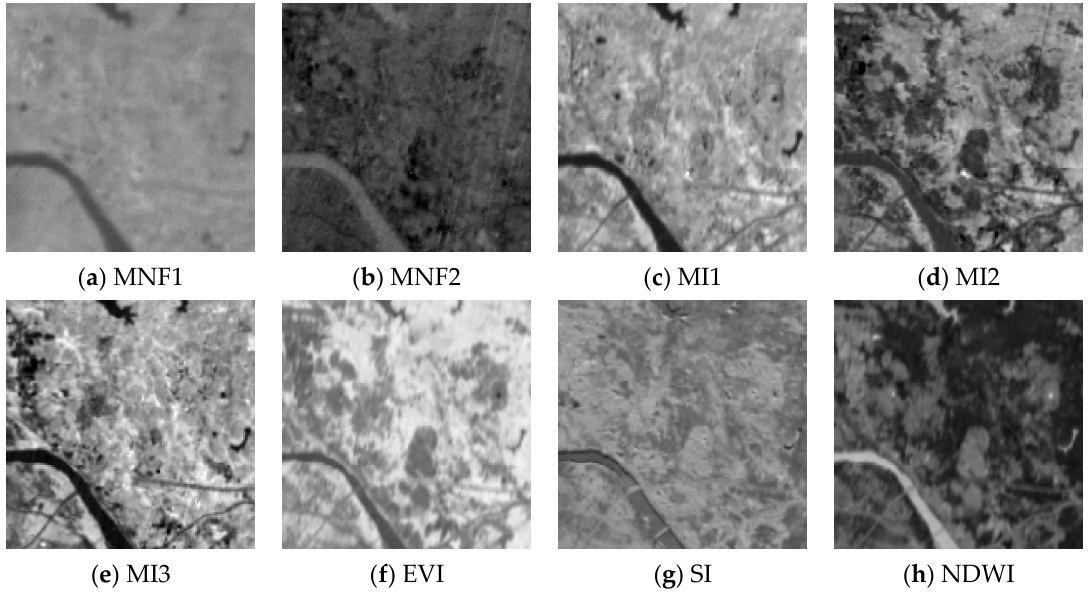
Figure 5. The spectral index feature map of local study area. MNF1: Minimum Noise Fraction feature 1; MNF2: Minimum Noise Fraction feature 2; MI1: mine index 1; MI2: mine index 2; MI3: mine index 3; EVI: Enhanced Vegetation Index; SI: Soil Index; NDWI: Normalized Difference Water